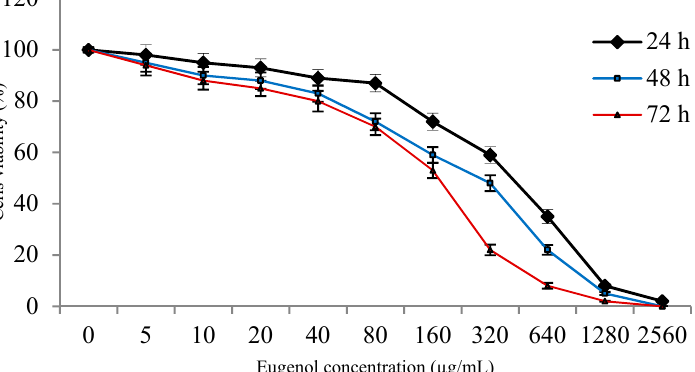
Figure 1. Effect of eugenol on the viability of adipose tissue-derived mesenchymal stem-like cells (ASCs). The viability of ASCs after treatment for 24, 48 and 72 h with different concentrations of eugenol was shown. Viability was expressed as percentage relative to that of eugenol non-treated cells. Data represent mean ± SD. ASCs: adipose tissue-derived mesenchymal stem-like cells.